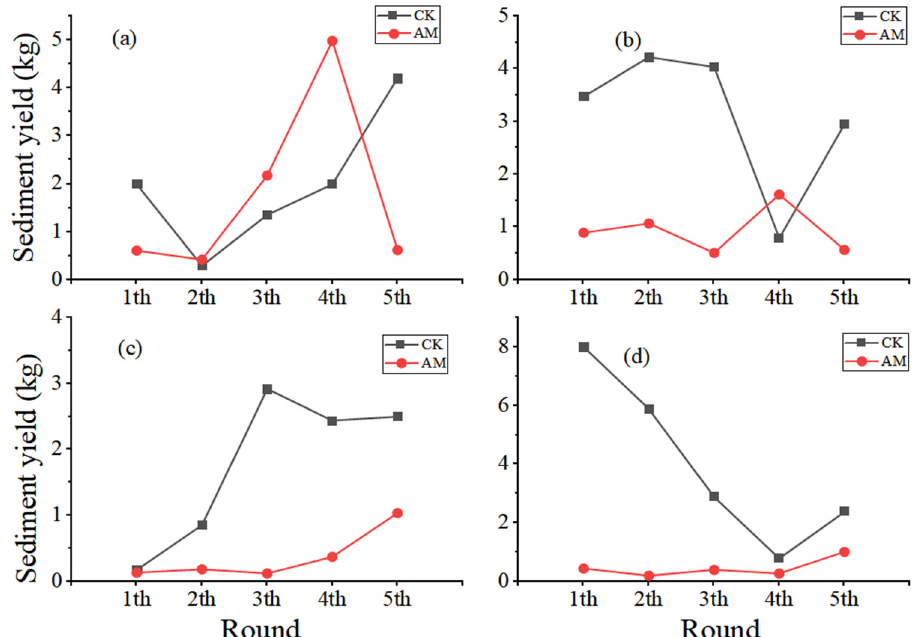
Figure 2. Variation in sediment yield in different soil troughs under simulated scouring in ( a ) Cynodon dactylon , ( b ) Lotus corniculatus , ( c ) Zoysia japonica , and ( d ) Astragalus sinicus .